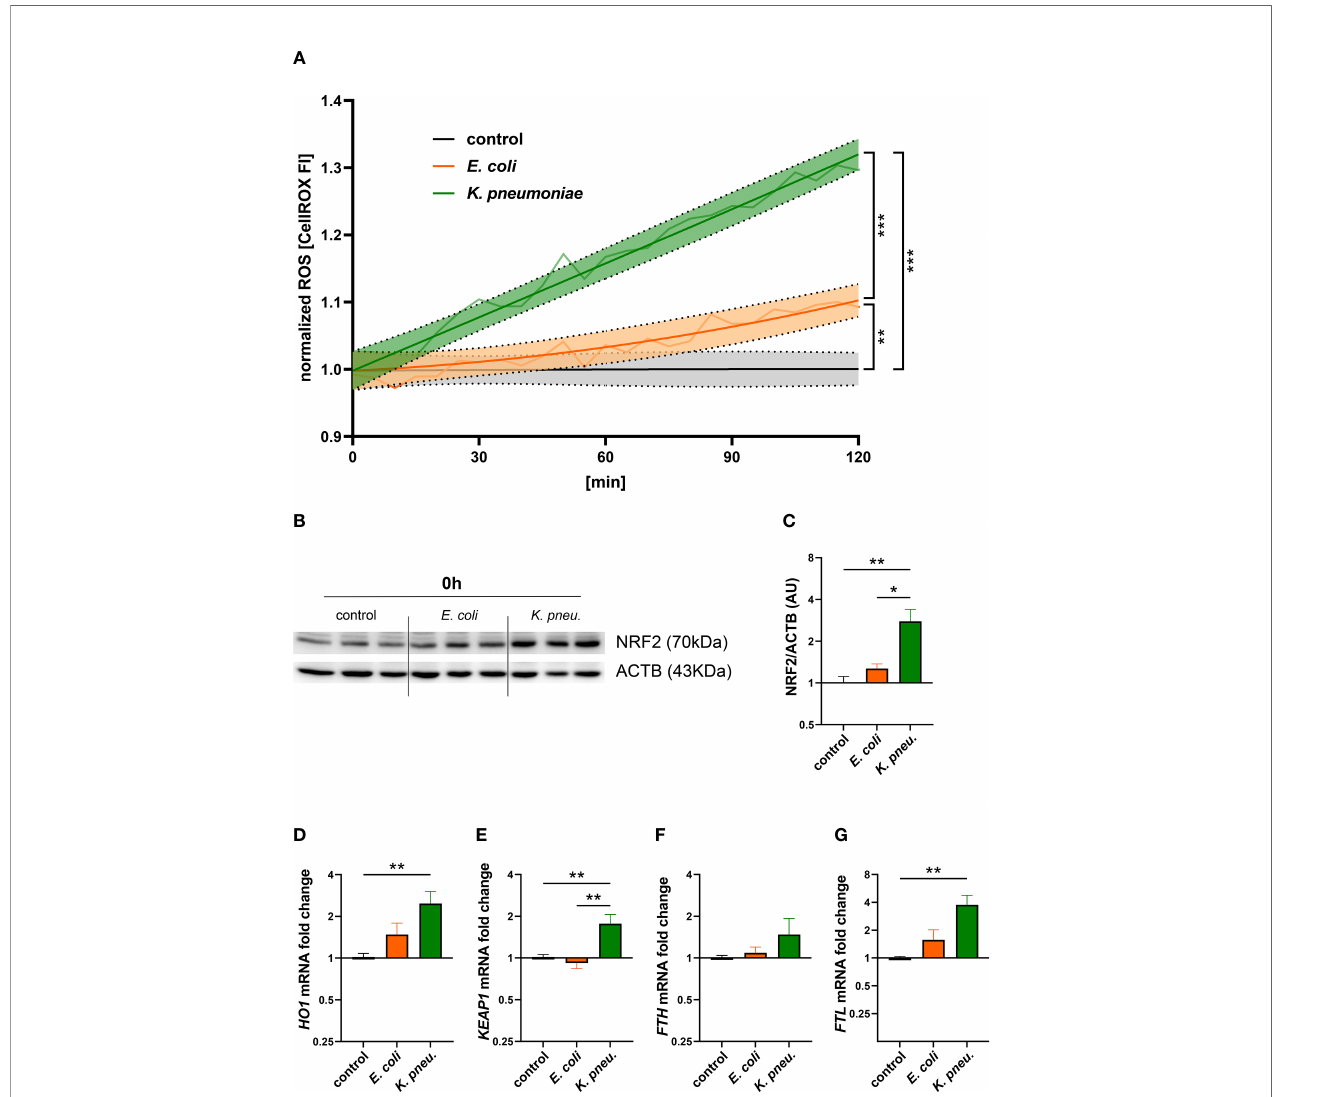
FIGURE 4 | Time-course of ROS formation during the 2h incubation phase in A549 cells infected with either E. coli or K. pneumoniae (A) . The means of fl uorescence intensity of three independent experiments are shown as a light colored line. Dark colored lines display a non-linear regression line- fi t with 95% CI as error bands. Results were normalized to uninfected controls. Statistical testing was performed for the 120min time point. Western blot (B) of NRF2 and corresponding densitometry of two separate experiments (C) in infected A549 cells. A549 cells were infected for 2h with E. coli or K. pneumoniae at MOI of 10, subsequently washed thoroughly and directly harvested. Data are shown as mean ± SEM of 2 separate experiments. Differential mRNA expression of NRF2-targeted genes HO1 (D) , KEAP1 (E) , FTH (F) , and FTL (G) in infected A549 cells. A549 cells were infected for 2h with E. coli or K. pneumoniae at MOI of 10, subsequently washed thoroughly and harvested after 6h of intracellular infection. Data are shown as mean ± SEM of three separate experiments. * denotes p<0.05, ** denotes p<0.01, *** denotes p<0.001 for post- hoc statistical testing. ROS, reactive oxygen species; K. pneu., K. pneumoniae ; NRF2, NF-E2-related factor 2; ACTB, b -actin; HO1, Heme oxygenase-1; KEAP1, Kelch-like ECH-associated protein 1; FTH, ferritin heavy chain; FTL, ferritin light